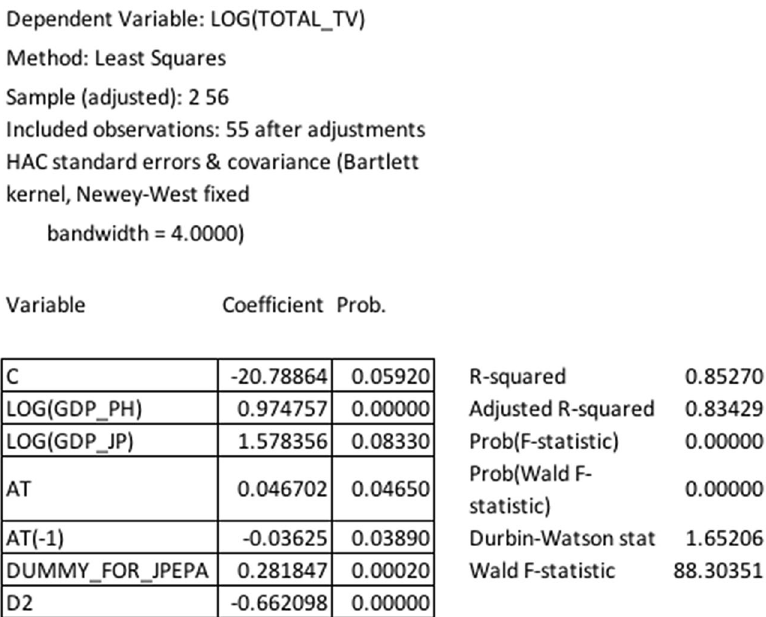
Table 2 Modified regression